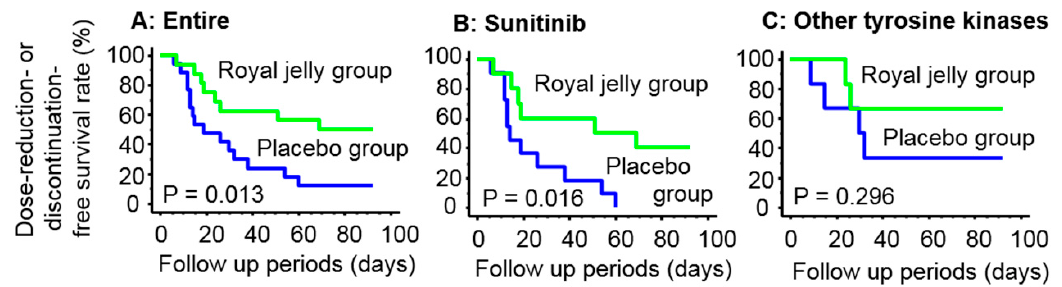
Figure 1. Kaplan–Meier survival curves of the dose-reduction- or discontinuation-free survival rate in the placebo and RJ groups. Dose-reduction- or discontinuation-free survival was better in the RJ group than in the placebo group for patients treated with any TKI ( A ) and sunitinib ( B ) ( p = 0.127 and 0.016, respectively). However, this difference was not observed in patients treated with other TKIs ( C ).